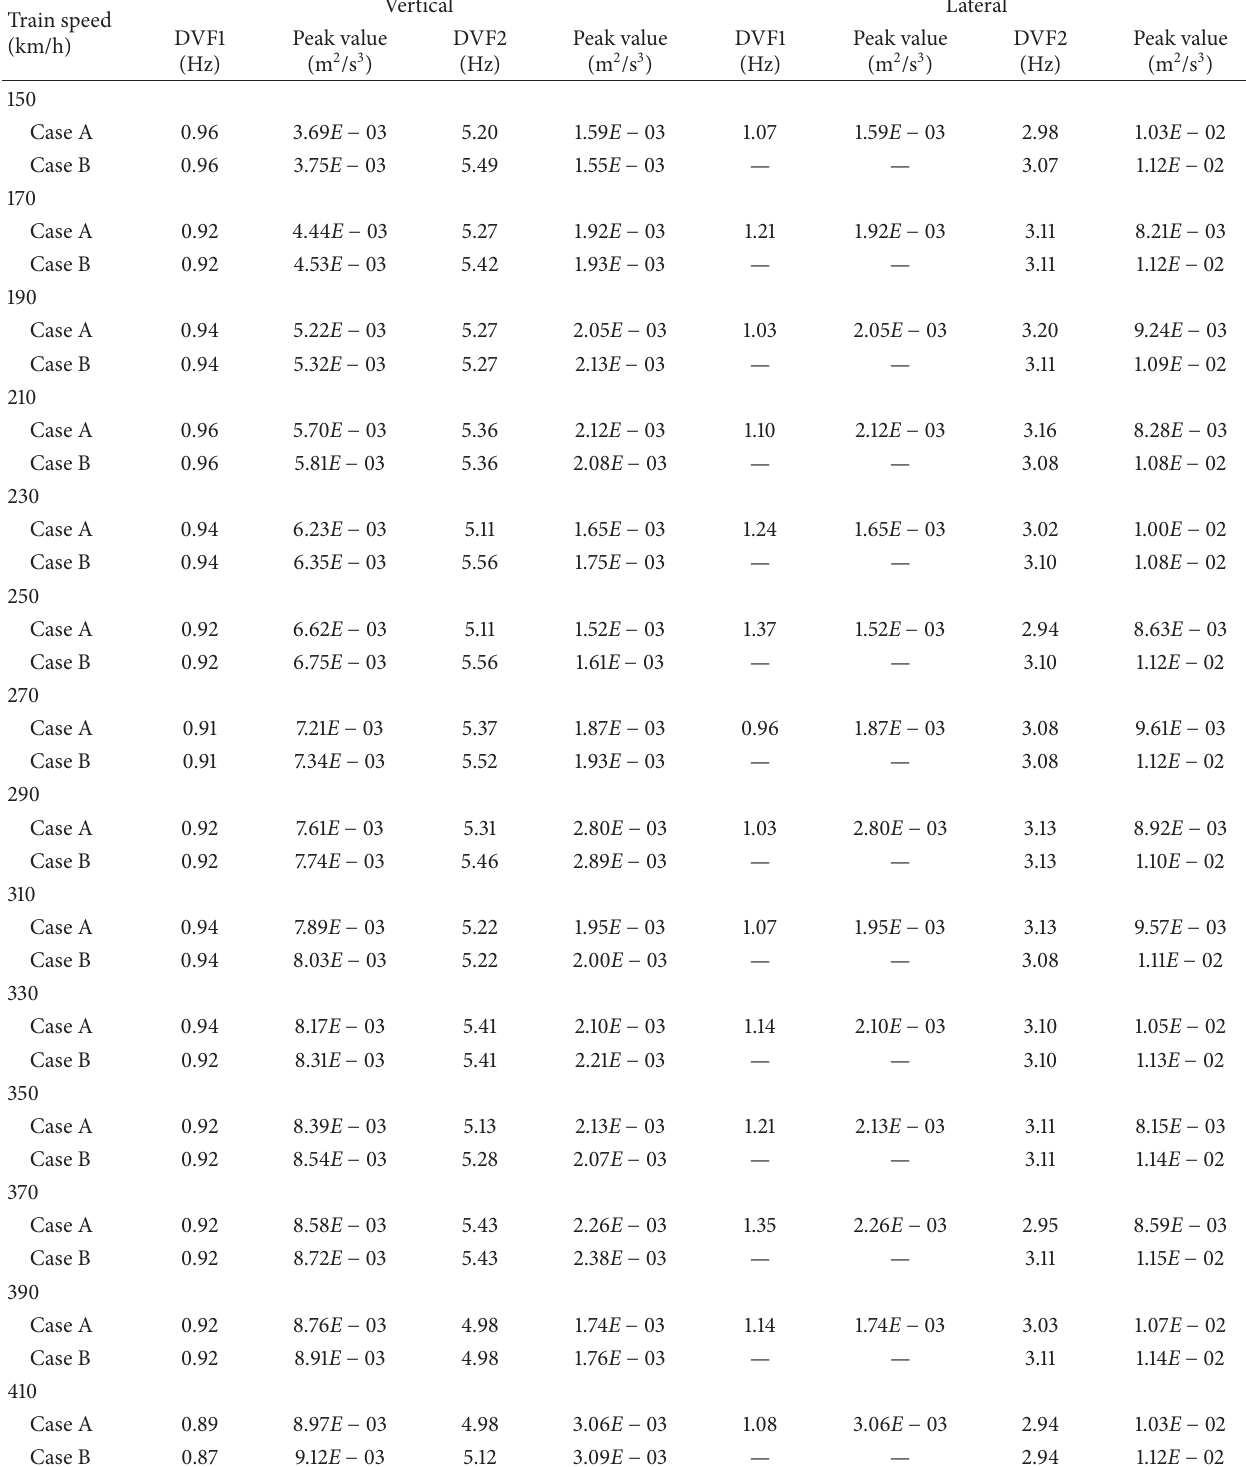
Table 5: Influence of train speed on PSDs of motor carbody